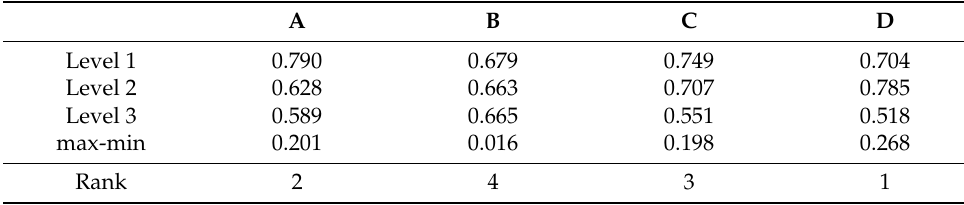
Table 7. Response of the MPCI